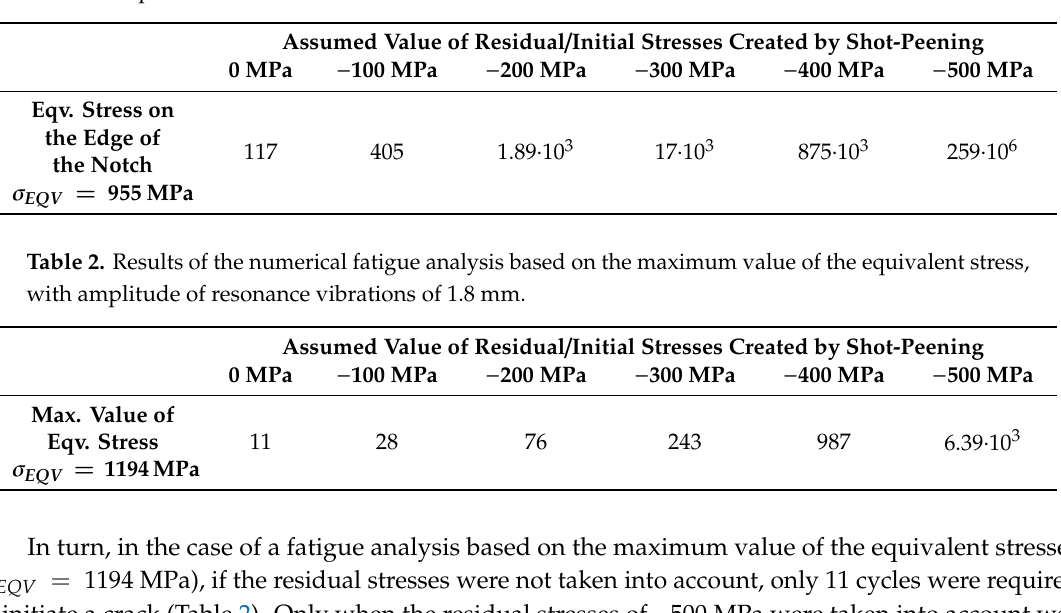
Table 1. Results of the numerical fatigue analysis based on the equivalent stress at the notched edge, with an amplitude of resonant vibrations of 1.8 mm.